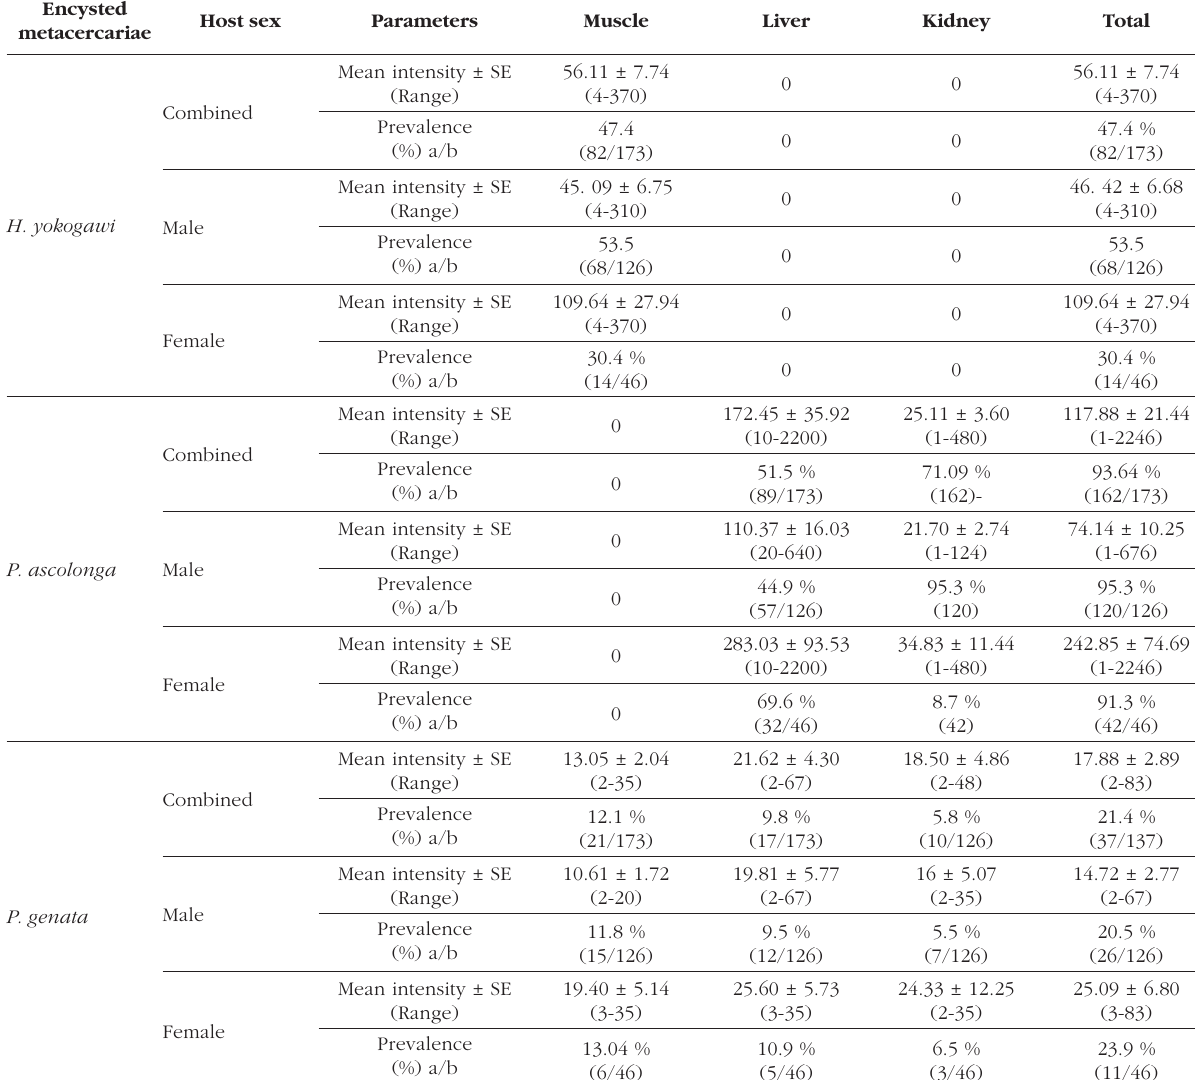
Table II. – Intensity (mean ± SE) with the range of infection and prevalence of heterophyid encysted metacercariae (MC) in T. zilli per host sex and